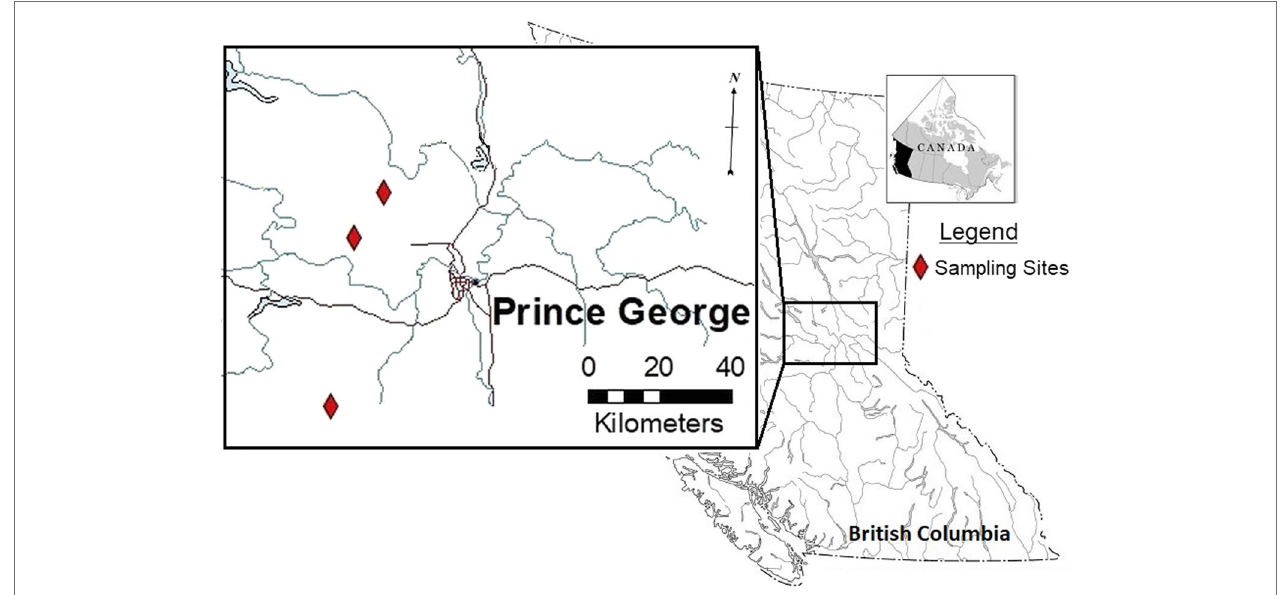
FIGURE 1 | Overview of locations used for floral sampling after operational treatment of glyphosate-based herbicides (GBH) in the Omineca Region of British Columbia,